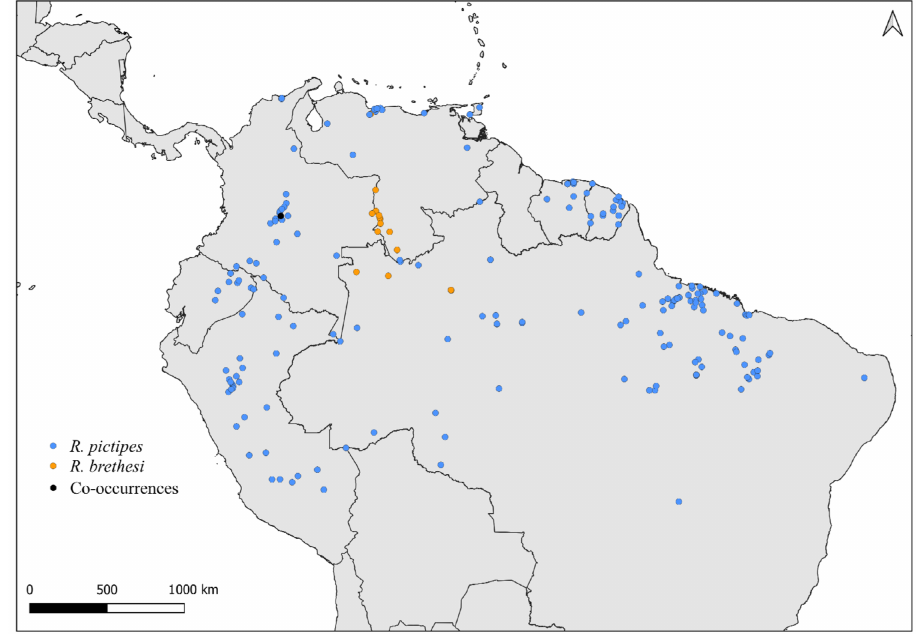
Figure 10. Distribution maps for R. brethesi and R. pictipes